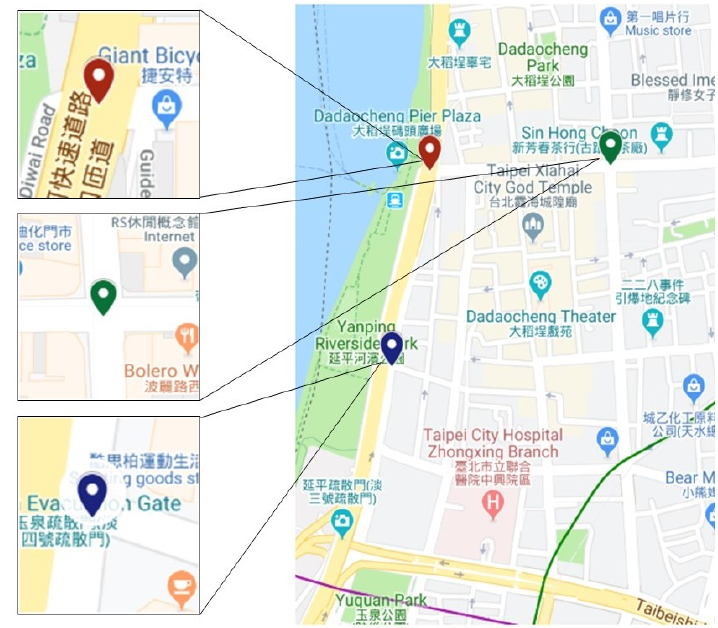
Figure 3. Crowded intersections in Taipei City.